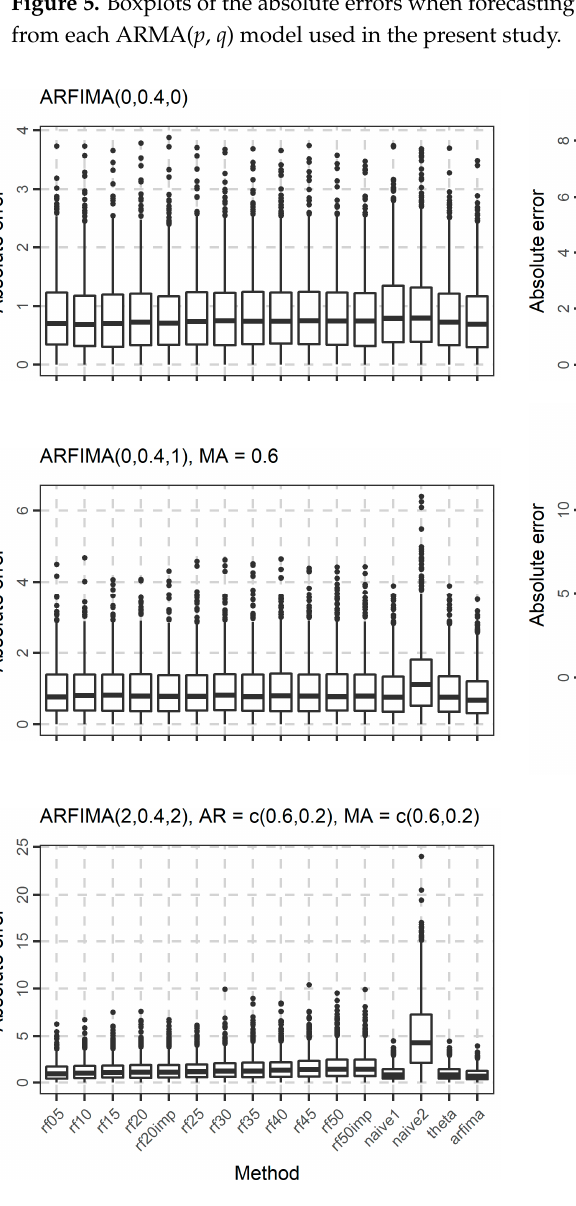
Figure 6. Boxplots of the absolute errors when forecasting the 101st value of 1000 simulated time series from each ARFIMA model used in the present study.